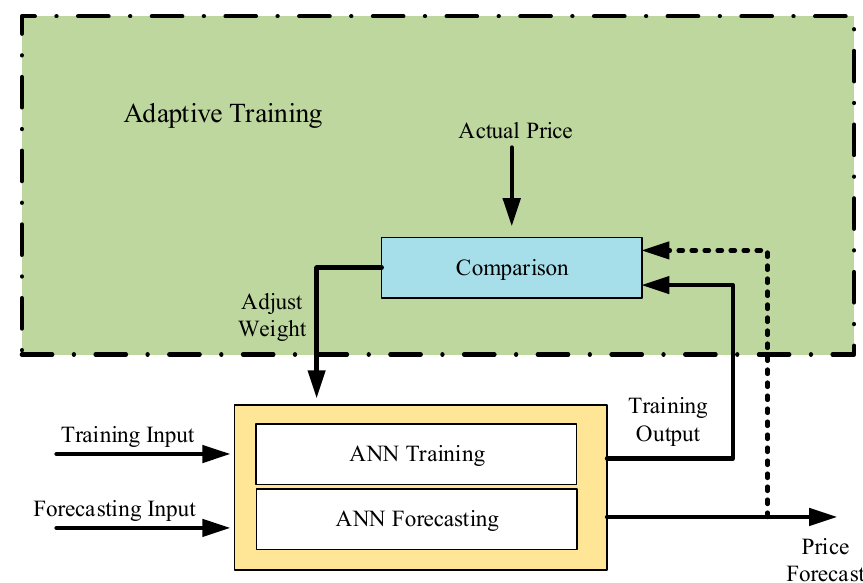
Figure 6. Price forecast based on neural network.